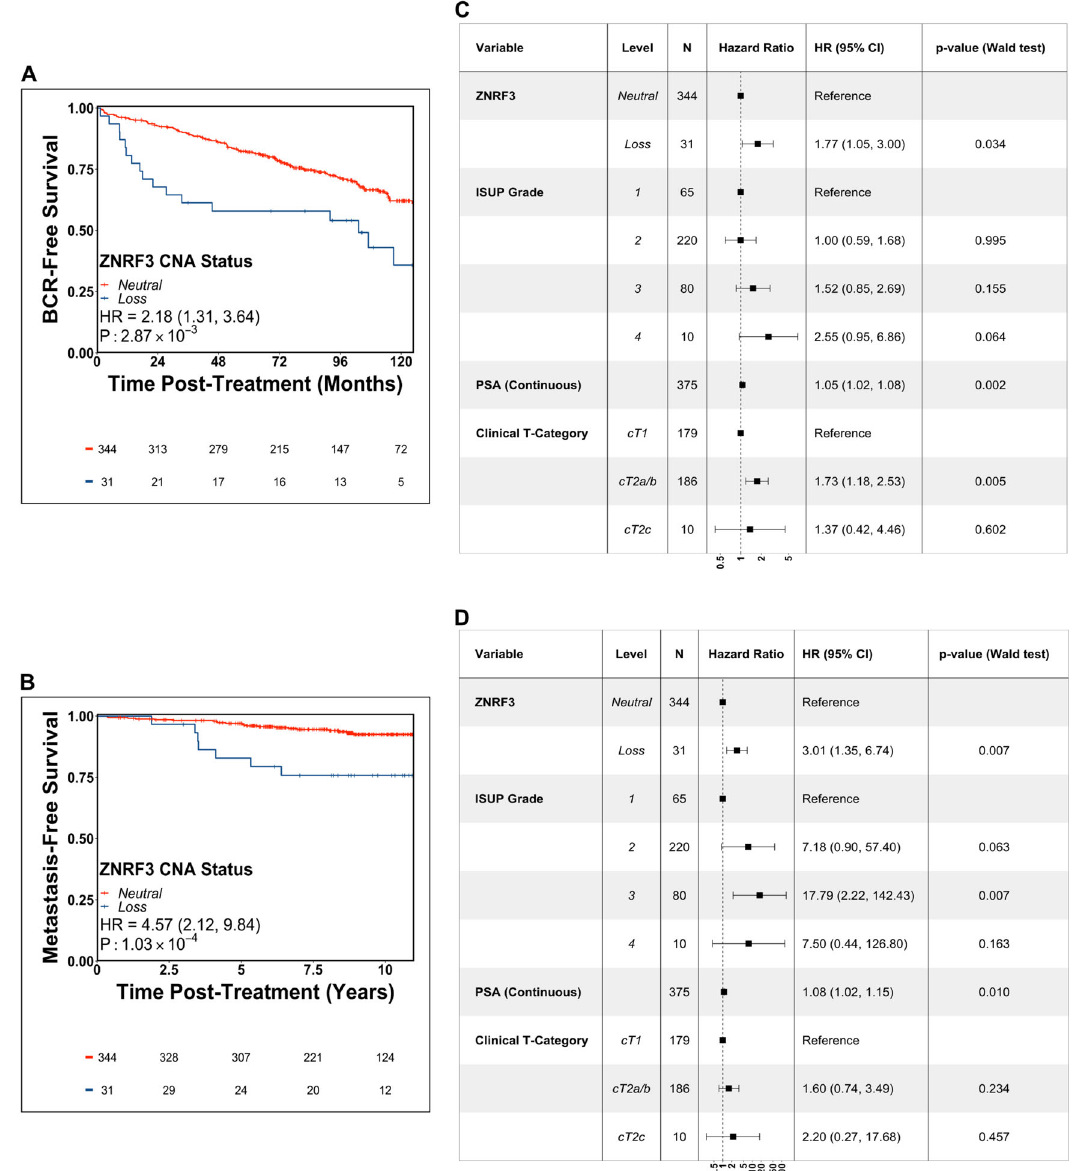
Fig. 3 ZNRF3 genomic loss is an independent prognostic factor for aggressive localized prostate cancer. Biochemical relapse-free rate ( A ) and metastatic relapse-free rate ( B ; mRFR) in CPCG patients with tumor specimens with (blue) or without (red) genomic loss of ZNRF3 . Two-sided p -values generated from a Wald test. C , D Forest plots of multivariable Cox proportional hazards analyses of ZNRF3 CNA status with clinical prognostic factors for biochemical relapse ( C ) and metastatic relapse ( D ). Error bars indicate 95% con fi dence interval of the reported hazard ratio. Source data are provided as a Source Data fi